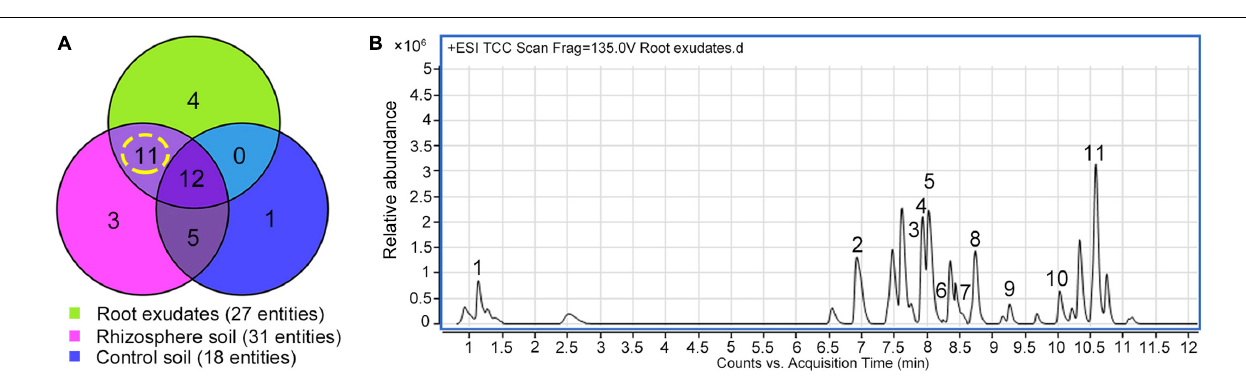
FIGURE 2 | Screening of the key metabolites in R. glutinosa root exudates which subsequently accumulated in its rhizosphere. (A) Venn diagram of metabolite distribution in root exudates of 7-day-old R. glutinosa seedlings and rhizosphere soil of 180-day-old R. glutinosa . (B) Typical total extracted compound chromatogram (TCC) of R. glutinosa root exudates at 7 days of